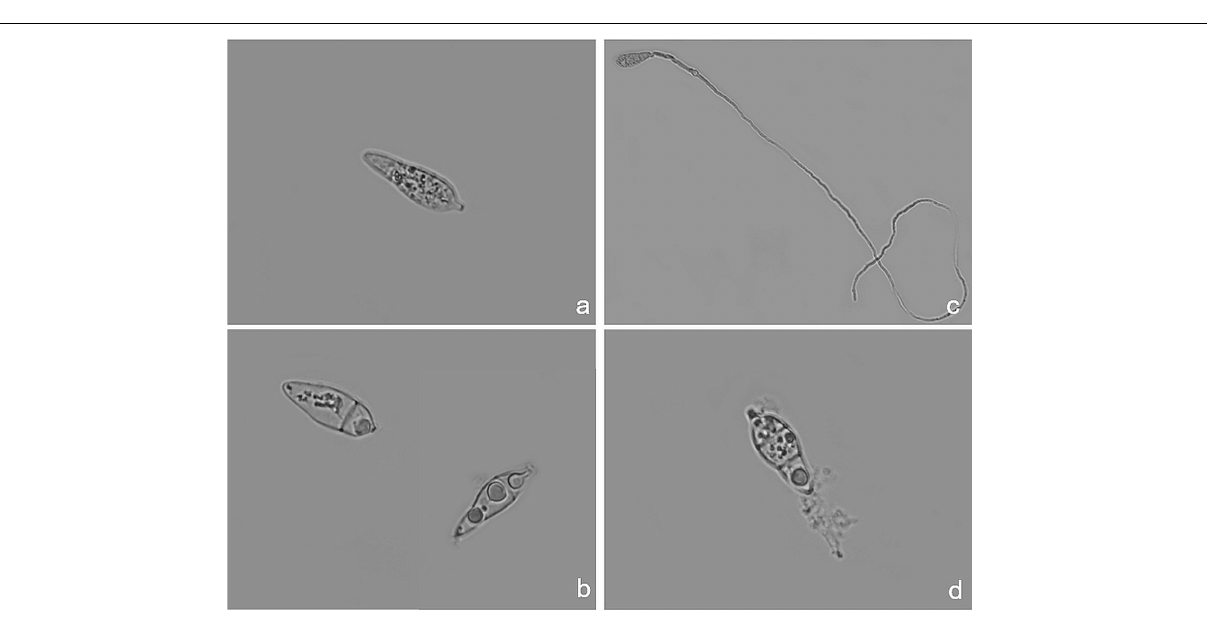
FIGURE 4 | Light microscopy pictures of Pyricularia oryzae (IT10 strain) conidia after incubation with Pep 4Rink in Potato Dextrose Broth (PDB) medium. (a) untreated P. oryzae conidium before peptide treatment; (b) non-germinated P. oryzae conidia at 48 h after peptide treatment, showing cytoplasmic agglutination; (c) untreated germinated P. oryzae conidium at 48 h; (d) early germinated P. oryzae conidium showing lysed hypha at 48 h from peptide